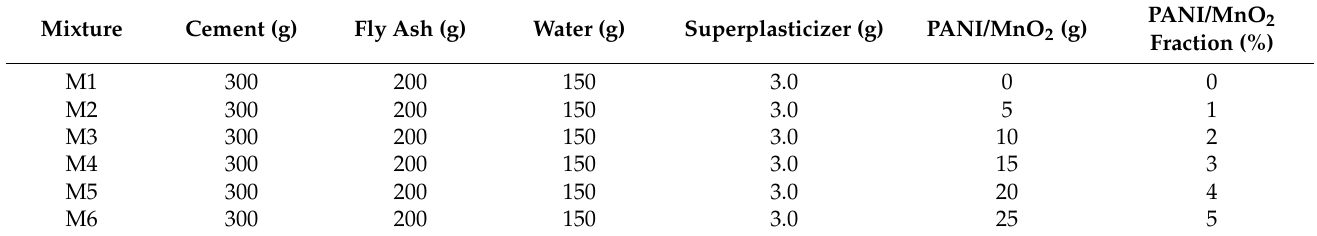
Table 1. Composition of cement paste